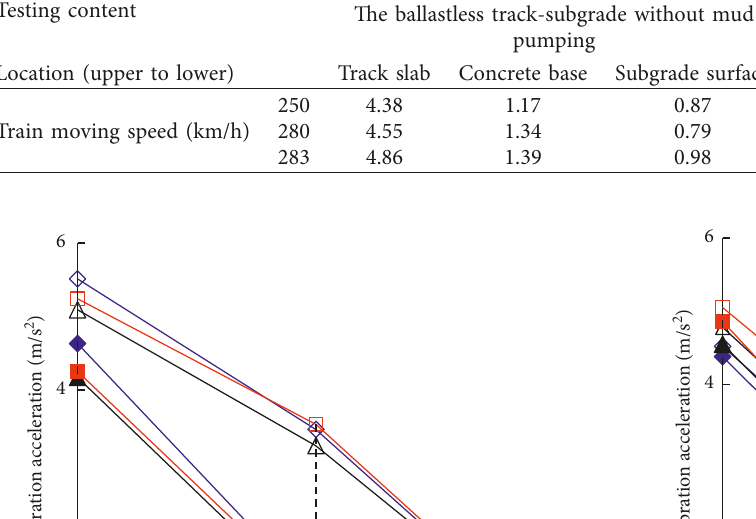
Table 4: The vertical vibration acceleration of the ballastless track-subgrade without mud pumping and after mud pumping reinforcement. Testing content